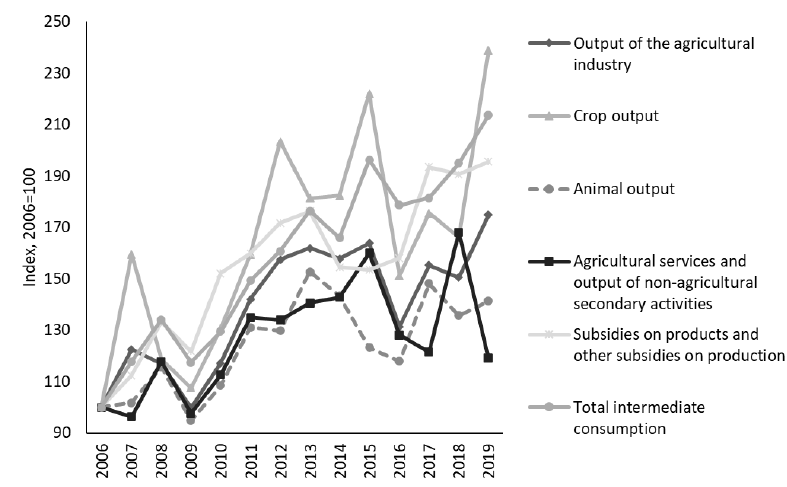
Fig. 1. Output of the agricultural industry, agricultural subsidies on products and production, and total intermediate consumption in Estonia, 2006‒2019 (current prices,